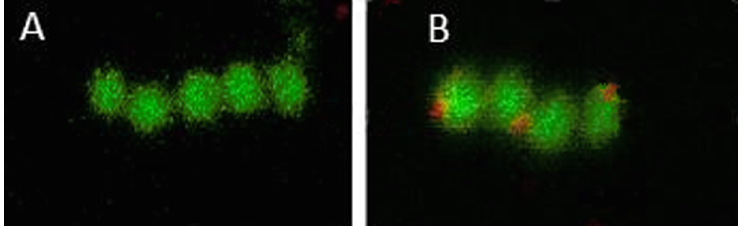
Fig 2. Confocal microscopy of the original enterococcal strain E . faecium L3 and its derivative with the fragment of streptococcal bac gene using an HRP labeled IgA. A- E . faecium L3 , B- E . faecium L3 Bac +.